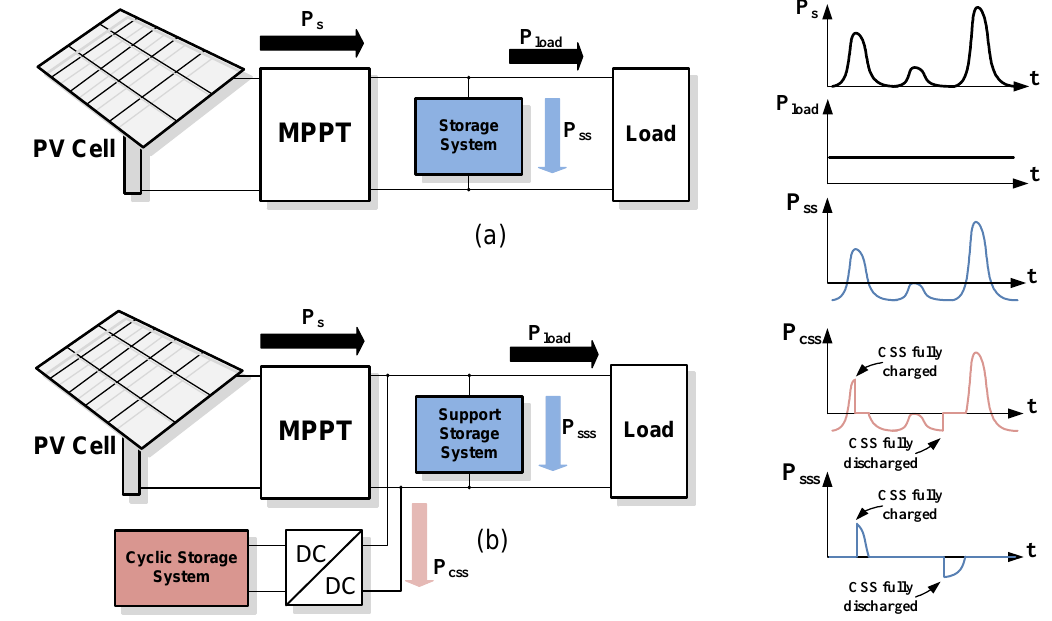
Figure 2. Conventional ESS scheme ( a ), Hybrid ESS scheme ( b Figure 2 . Conventional ESS scheme ( a ), Hybrid ESS scheme ( b ).